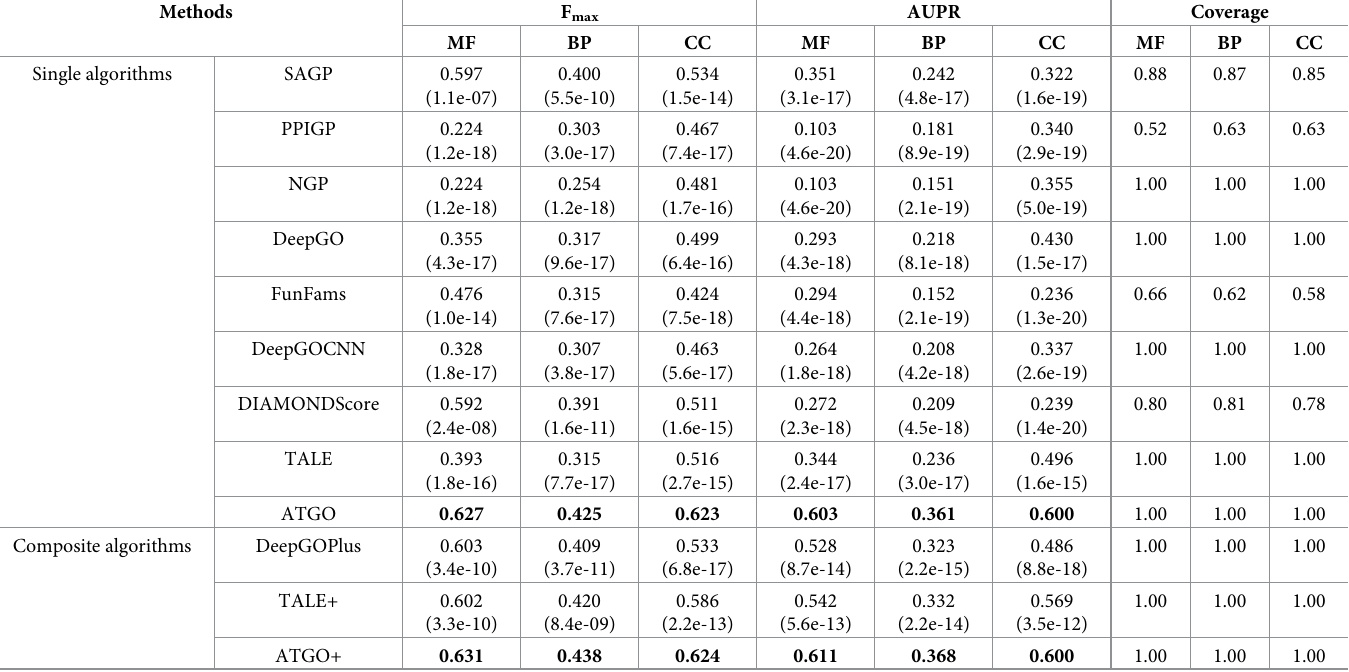
Table 1. The summary of the proposed ATGO/ATGO+ and other 10 competing GO prediction methods on the 1068 benchmark proteins. p -values in parenthesis are calculated between ATGO and other single-based methods and between ATGO+ and other composite methods by two-sided Student’s t-test. Specifically, the proposed ATGO and ATGO+ are repeatedly implemented with 10 times on the benchmark dataset to generate the corresponding performance evaluation indices, which are com- pared with the fixed evaluation index generated by the competing method to calculate p -value using two-sided Student’s t-test. Bold fonts highlight the best performer in each category. Coverage is the ratio of the number of proteins with available prediction scores divided by the total number of test